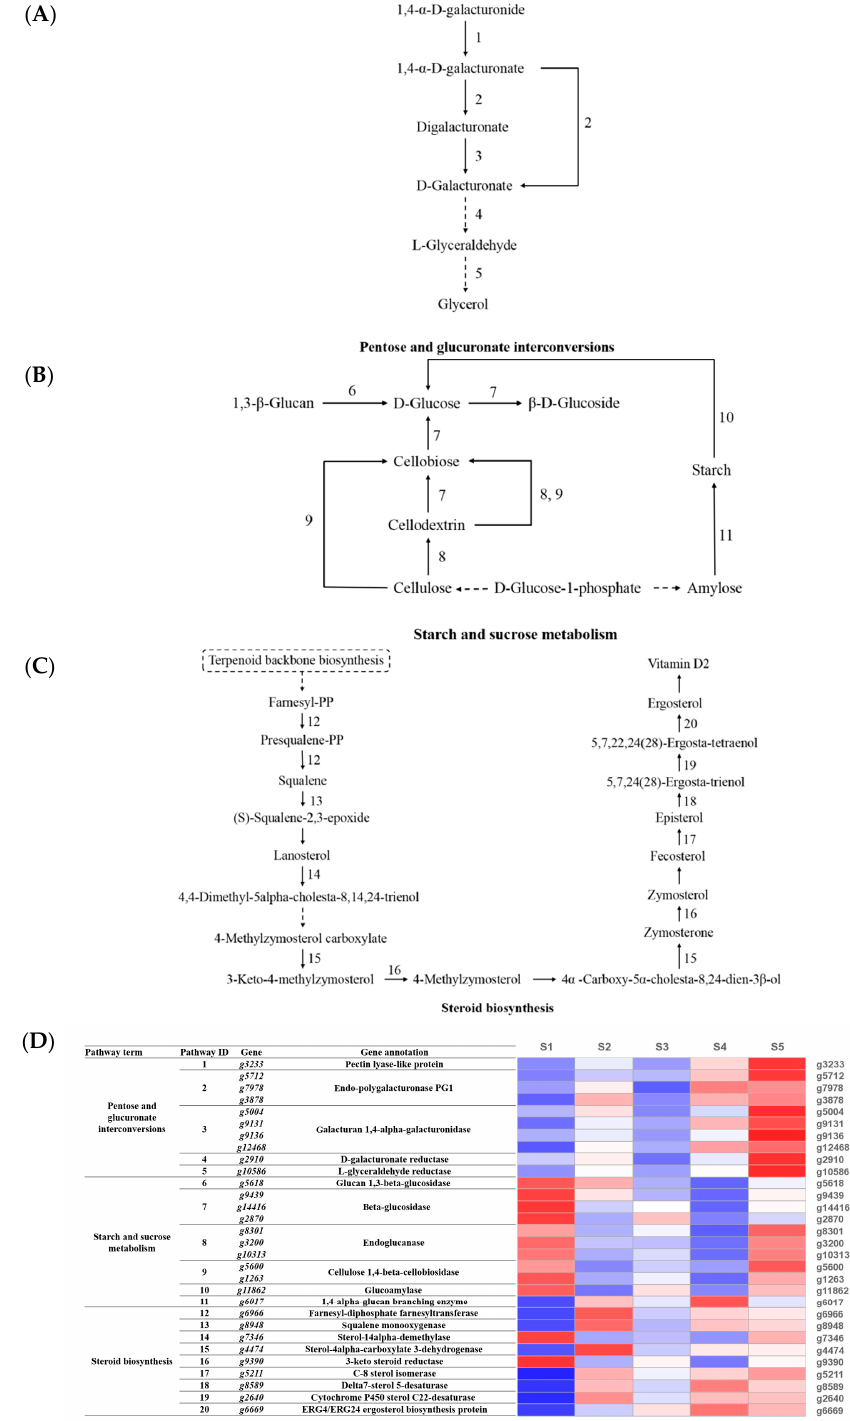
Figure 6. Polysaccharide- and triterpenoid-related pathways of isonuclear alloplasmic based on transcriptome analysis. Dashed lines indicate indirect connections or unknown reactions. The number along the arrows indicate pathway IDs in ( C ). ( A ) Pentose and glucuronate interconversions pathway. ( B ) Starch and sucrose metabolism pathway. ( C ) Steroid biosynthesis pathway. ( D ) Changes in expression of genes involved in pathways. Red to blue color indicated the highest to lowest relative expression level.